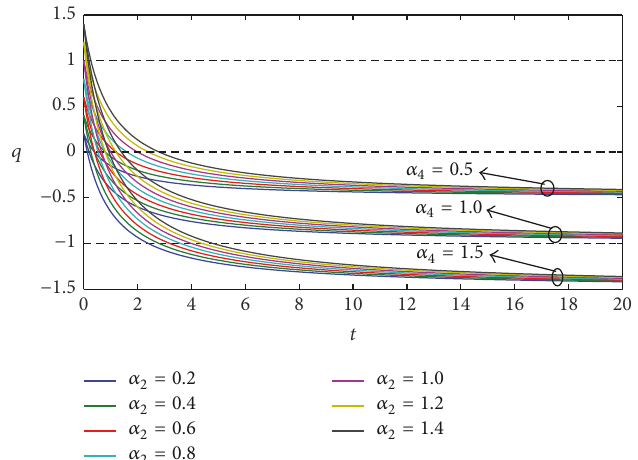
Figure 2: Variation of deceleration parameter against time for fixed 𝛼 4 and different 𝛼 2 .